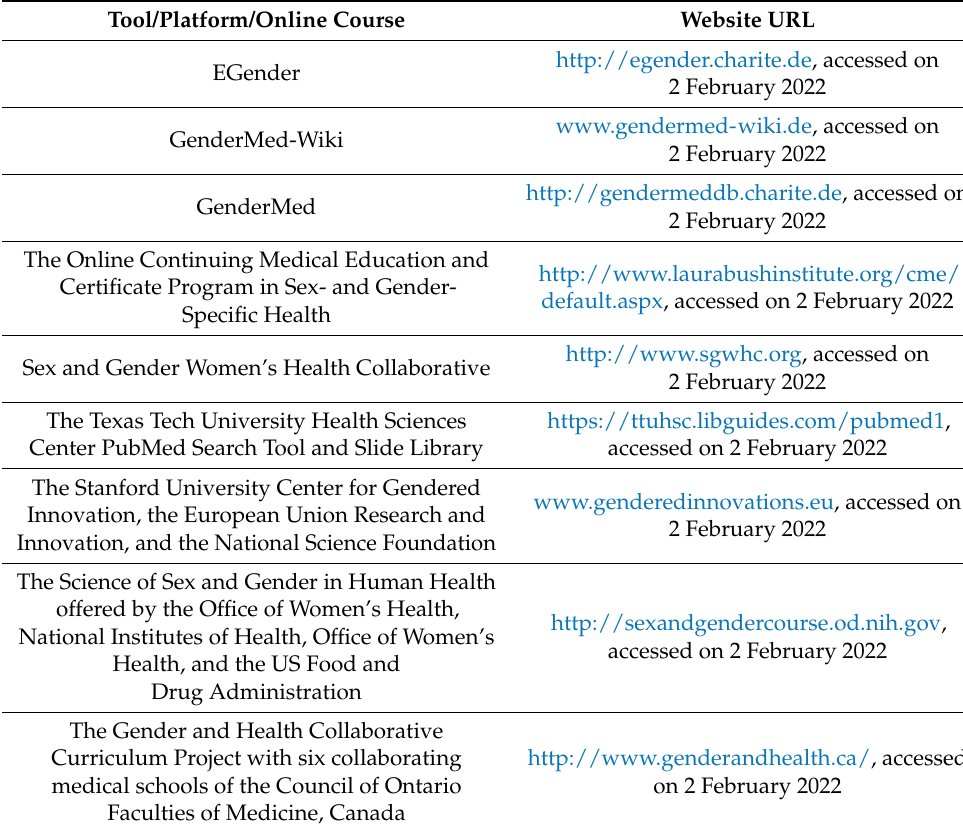
Table 2. Available tools/platforms/online courses for sharing and disseminating knowledge related to sex- and gender-based